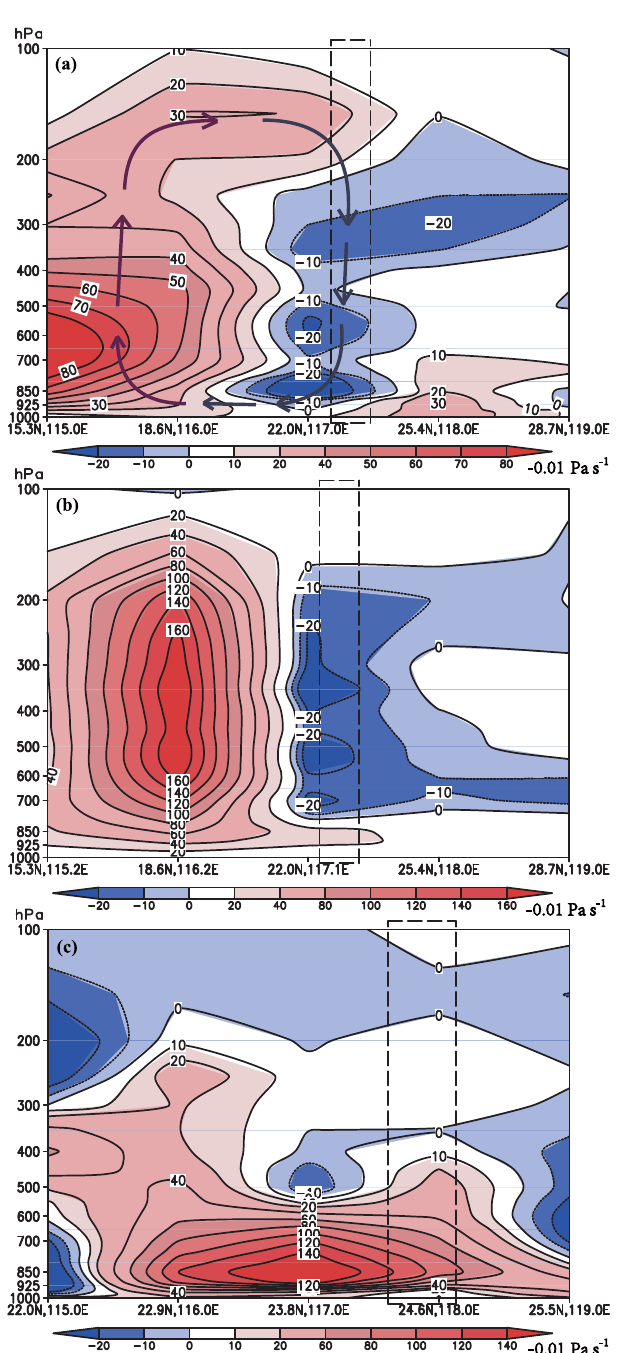
Figure 5. Vertical cross sections of vertical velocity ( − 0.01Pas − 1 ) along the three straight lines linking XQR and the centers of Ty- phoon Hagibis in Fig. 2 at (a) 14:00 13 June, (b) 20:00 13 June and (c) 20:00 15 June 2014. Two dashed boxes denote the location of XQR. The lines with arrows indicate the in-up-out-down overturn- ing air flows in the vertical direction of typhoon.